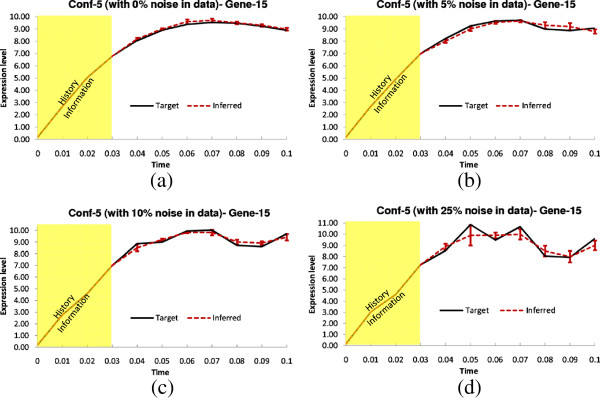
Dynamics for Gene-15 of Conf-5. Solid lines and dotted lines indicate respectively target and inferred (by TDSS) time-expressions in (a) Noise free data (b) 5% Noise in data (c) 10% Noise in data (d)25% Noise in data. The yellow region indicates the history information and the error bars indicate 95% confidence interval.